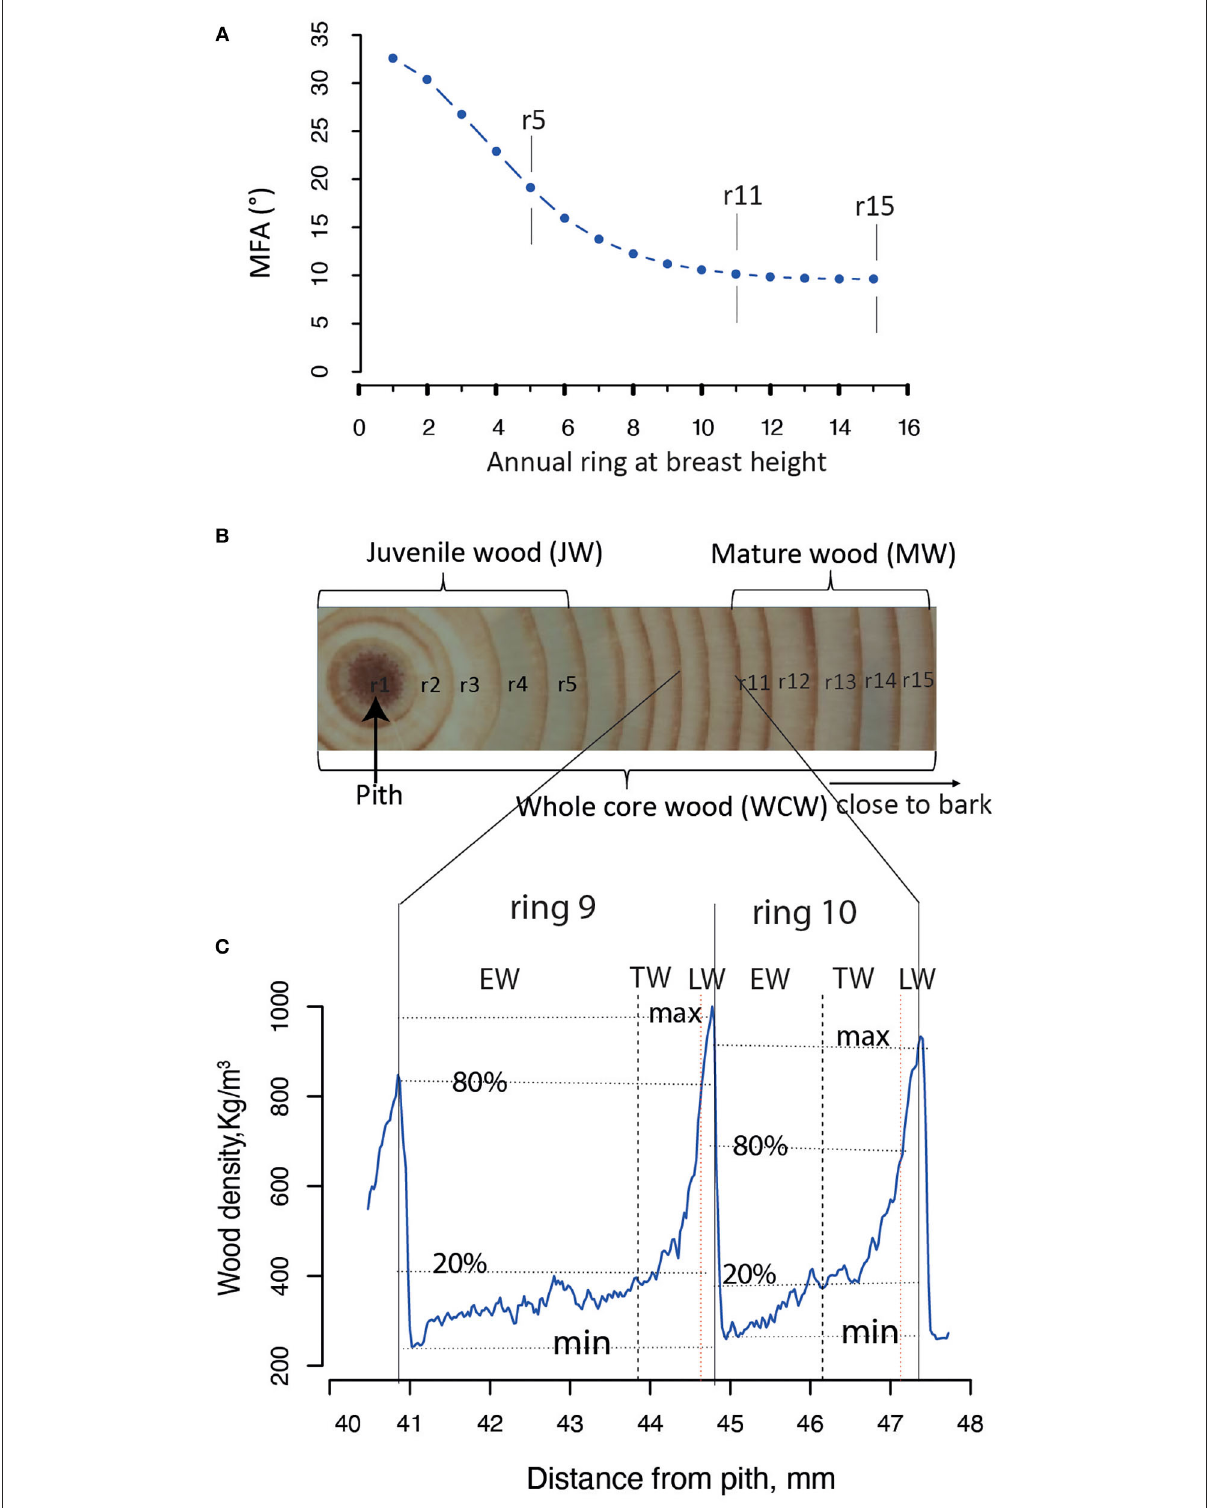
FIGURE2 Definition of different wood sections in Picea abies . (A) The mean microfibril angle (MFA) for each annual ring at the breast height (1.3m). All the SilviScan samples from Höreda trial were used to estimate the year ring mean value for MFA. (B) The juvenile wood (JW) and mature wood (MW) were defined based on a previous study (Hayatgheibi et al., 2018); JW: rings 1–5, MW: rings 11–15. The whole core wood (WCW) was defined as year rings from pith to bark (rings 1–15). (C) Each annual ring wood (ARW, e.g., rings 9 and 10) was demarcated into earlywood (EW), transition wood (TW), and latewood (LW), based on a “20–80” wood density threshold definition according to the previously published paper (Lundqvist et al.,